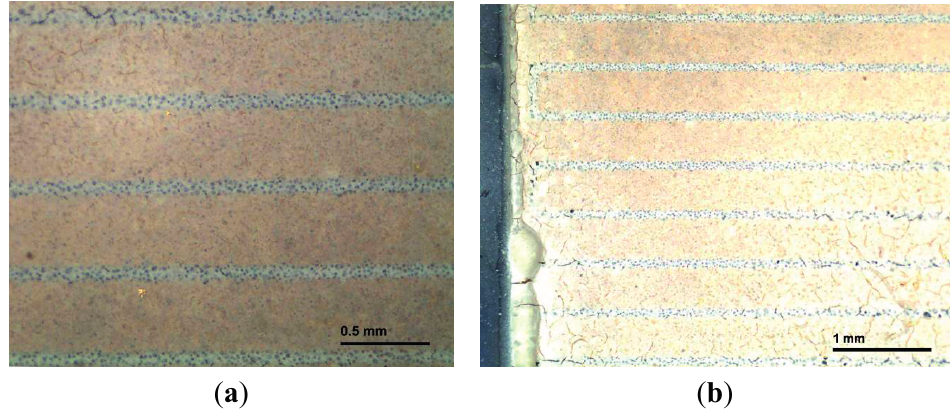
Figure 9. ( a ) Magnified pictures of the film thermally treated at 550 °C for 1 h; ( b ) Delamination at the edges of the interdigitated capacitor.